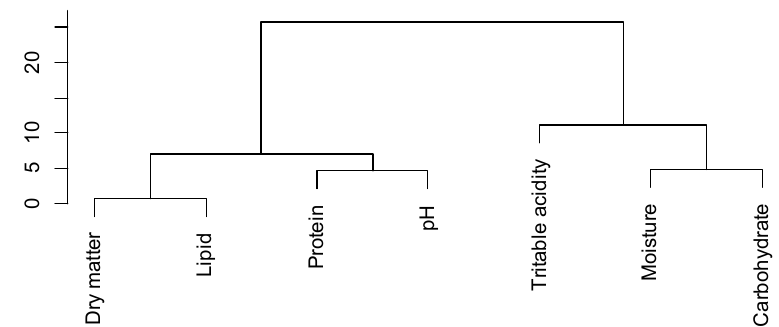
Figure 6. Hierarchical classification of tomato parameters.